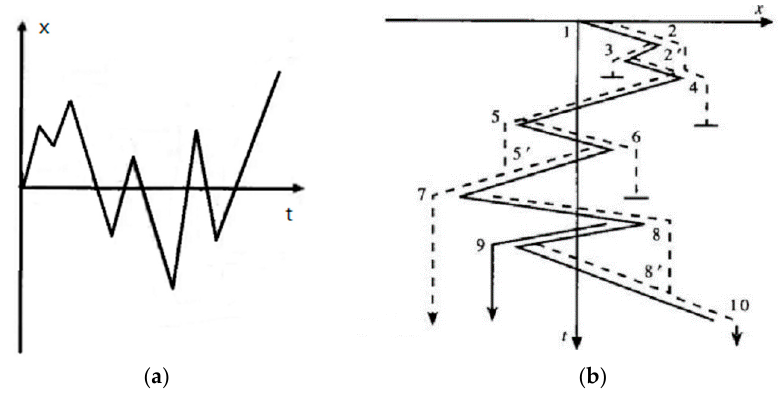
Figure 7. Rain flow counting principle schematic diagram. ( a ) A sequence of random load data, ( b ) Clockwise rotation of 90 degrees of random load data.